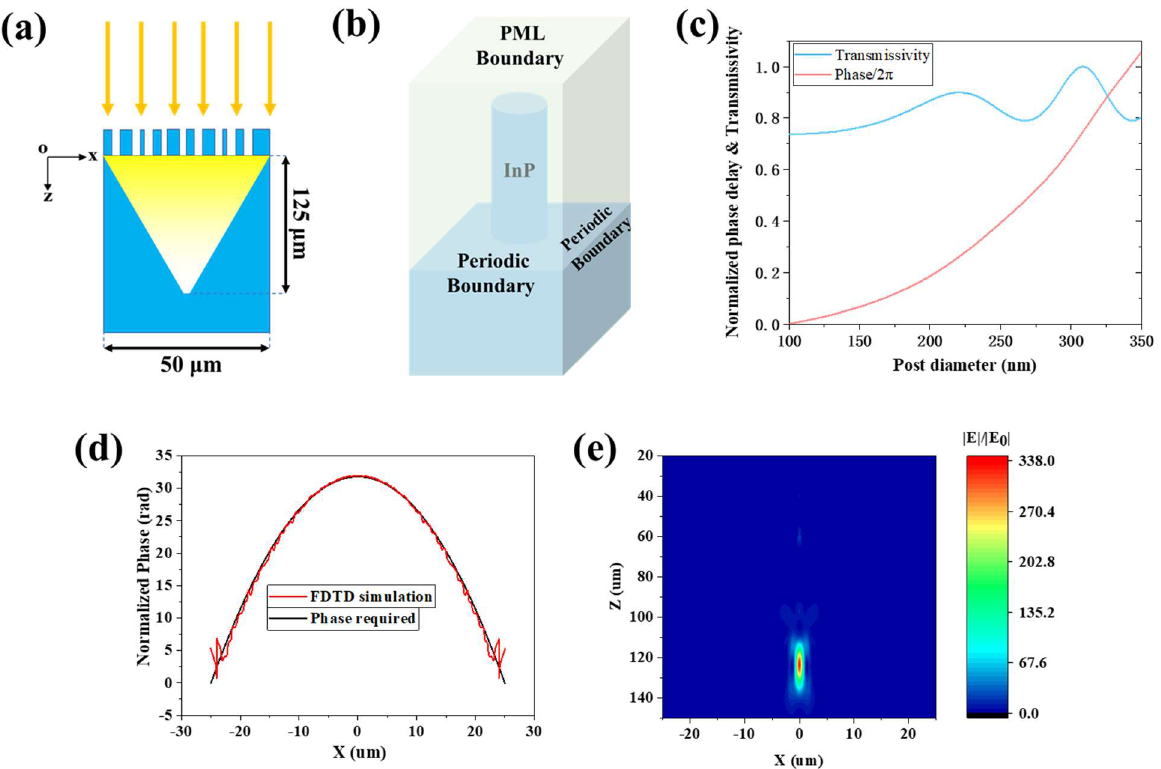
Figure 1. ( a ) Schematics of the InP solid-immersion metalens sectional view. ( b ) The setup of the unit cell simulations. ( c ) Simulated transmissivity and phase of the unit structure as a function of the post diameter with period of 400 nm. ( d ) The required phase profile (black curve) and the computed phase profile of our design (red curve) along the x-axis cutting through the center of the lens. ( e ) Simulated relative E-field intensity profiles of the metalens in the xz-plane (x from −25 μm to 25 μm, z from 20 μm to 150 μm).